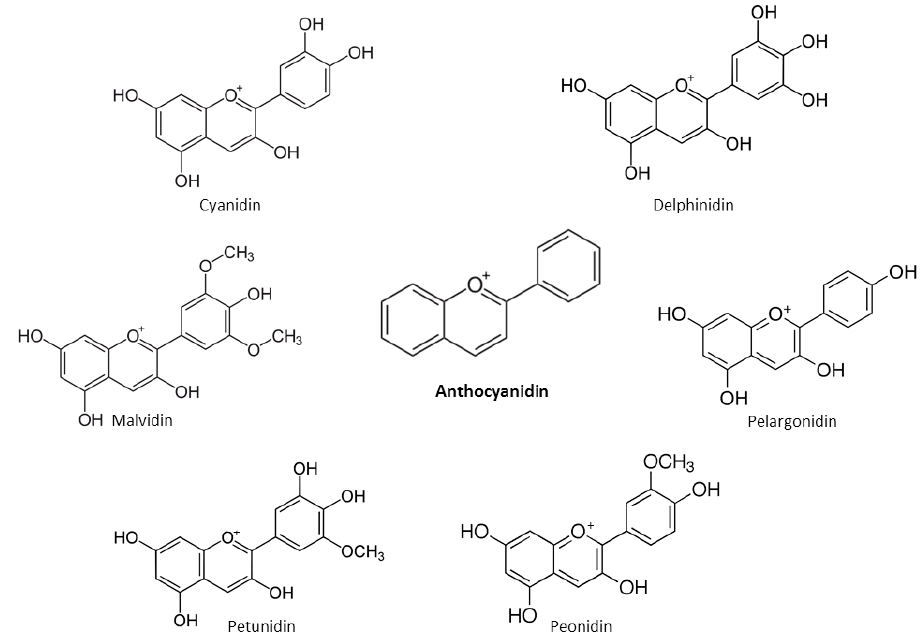
Figure 7. Chemical structures of main anthocyanidins.